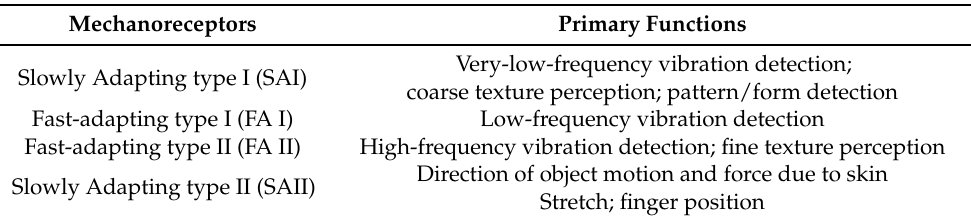
Table 2. Human skin mechanoreceptors (adapted from